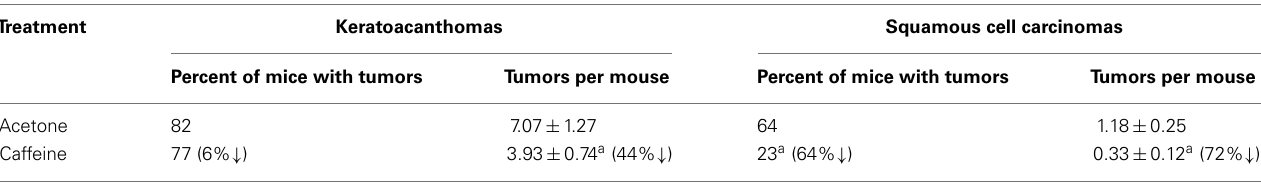
High-risk UVB-pretreated SKH-1 mice (30/group) were treated topically with 100 µ l acetone or caffeine (6.2 µ mol) in 100 µ l acetone once daily 5days a week for 18weeks.The numbers in parentheses represent percent inhibition. Each value represents the mean ± SE a p < 0.01.Taken from Lu et al. (2002). (“high-risk mice”) (Lou et al., 1999). Treatment of these UVB- tumor formation. The inhibitory effect of topical applications of pretreated “high-risk mice” with oral caffeine (Lou et al., 1999) caffeine on tumor formation in high-risk mice is shown in Table 2 . or with topical applications of caffeine (Lu et al., 2002) inhibited Treatment of high-risk mice with topical applications of